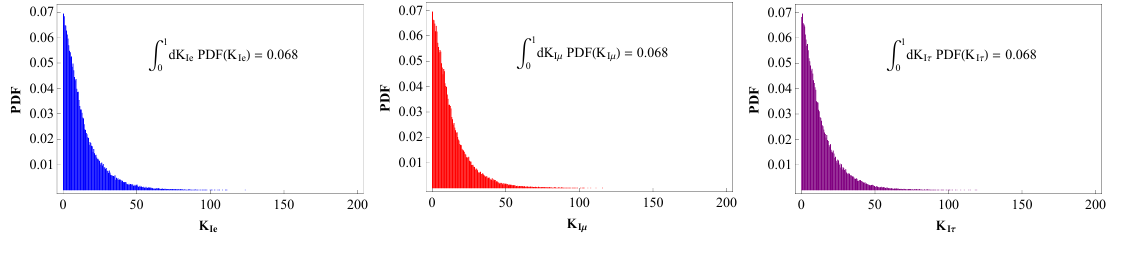
Figure 7. Same as in (cid:12)gure 5 but for m 1 = 0 : 01 eV.